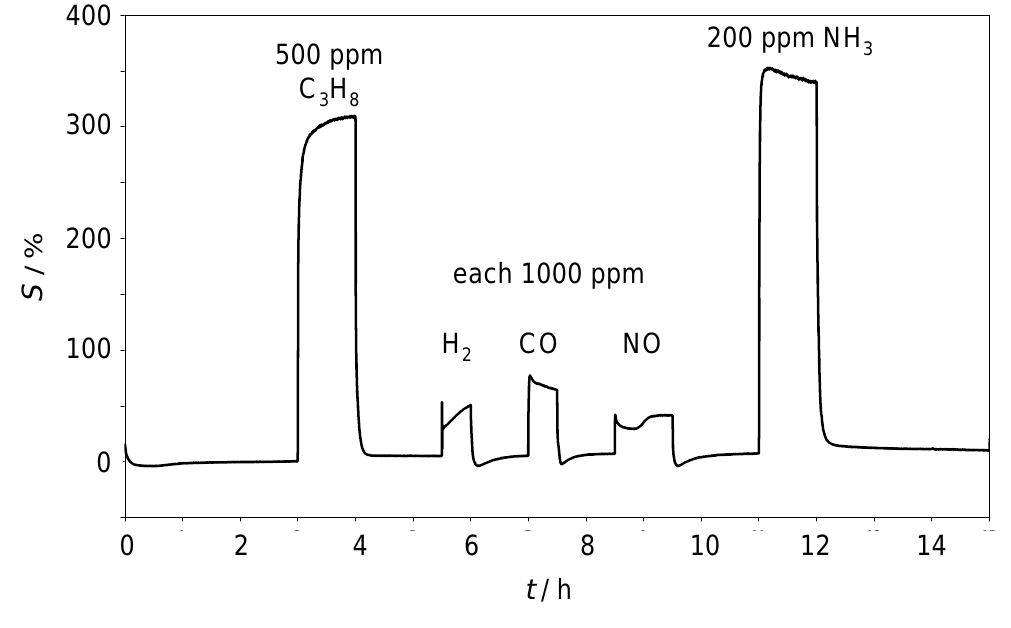
Figure 6. Sensitivity S over t at 3 Hz and 350